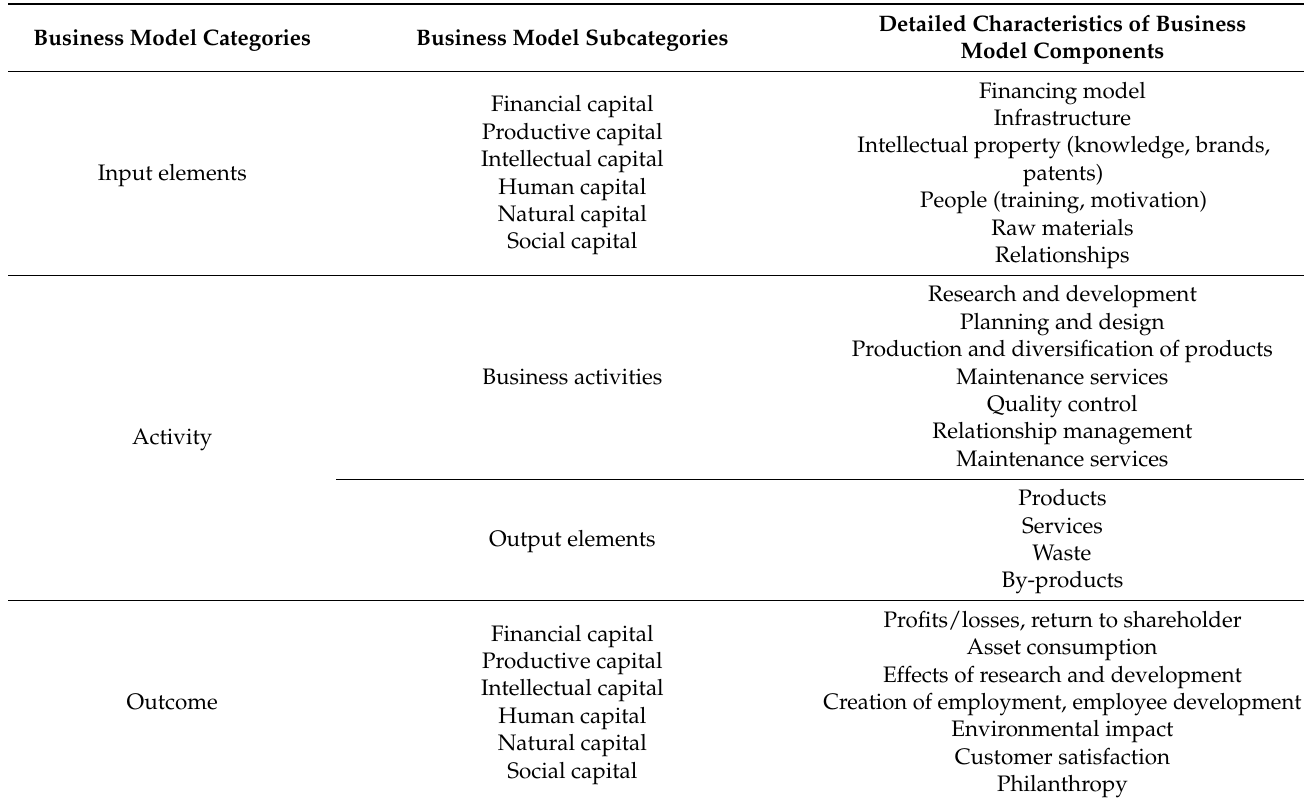
Table 1. Components, categories, and detailed characteristics of the business